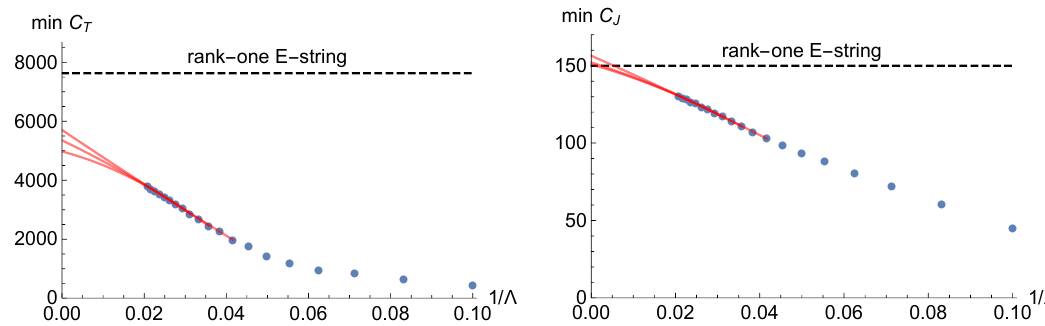
Figure 3 . The lower bounds on C T and C J at di(cid:11)erent derivative orders (cid:3) for interacting theories with E 8 (cid:13)avor group. Also shown are the extrapolations to in(cid:12)nite derivative order using the quadratic ansatz (8.1), as well as the values in the rank-one E-string theory.